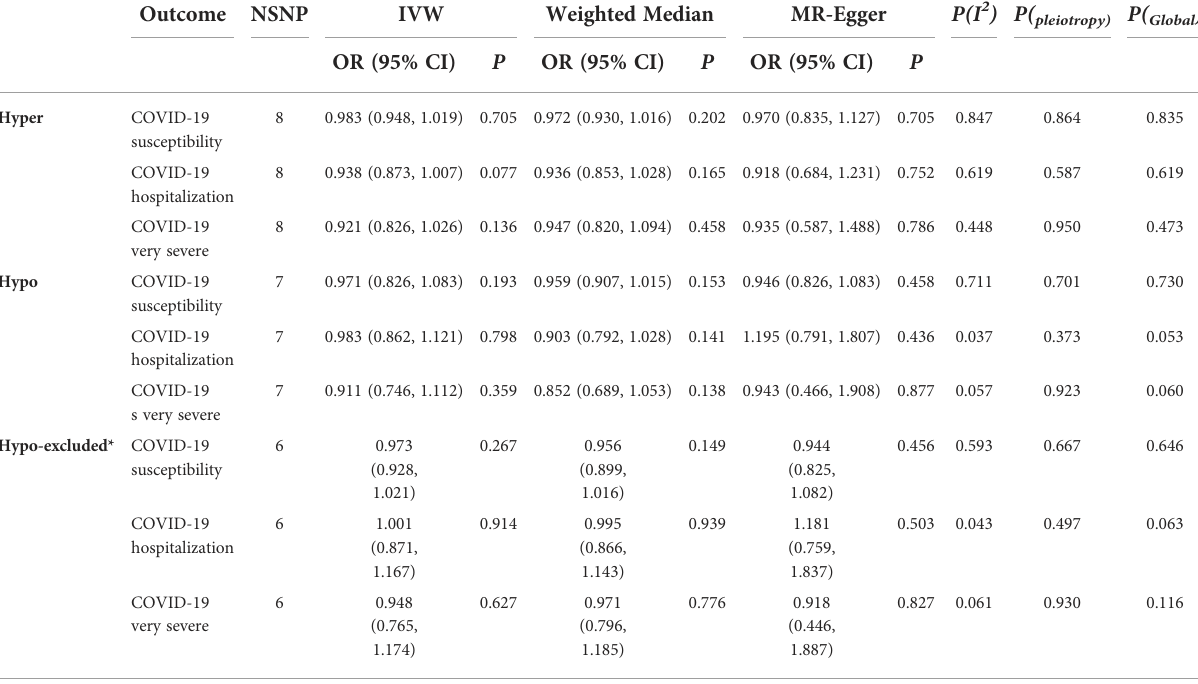
TABLE 2 MR estimates for the causal effect of thyroid dysfunction on